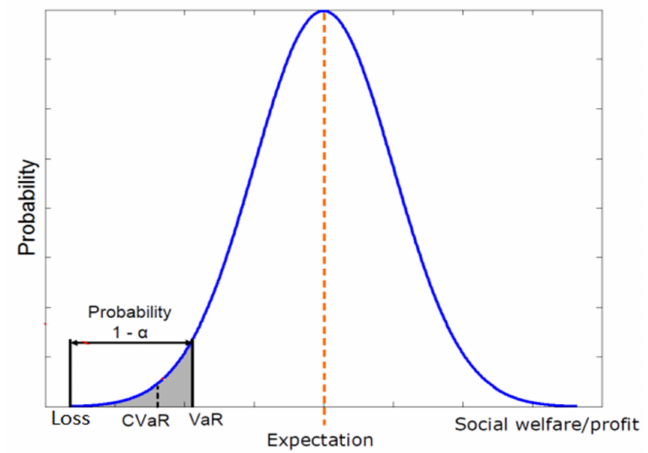
Figure 1. Risk assessment tools representation